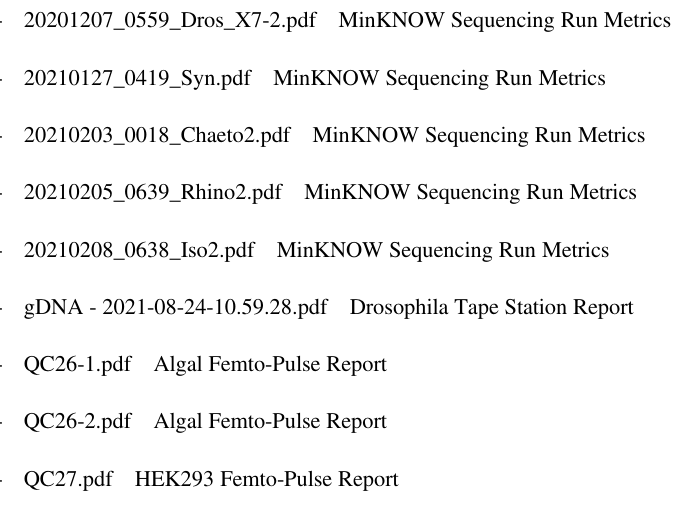
figshare: Video of robot-assisted organic extraction of DNA (RBI LabDroid Maholo). https://doi.org/10.6084/m9. figshare.19189466.v1 (Liu, Villar-Briones, Luscombe, and Plessy, 2022). Data are available under the terms of the Creative Commons Attribution 4.0 International license (CC-BY